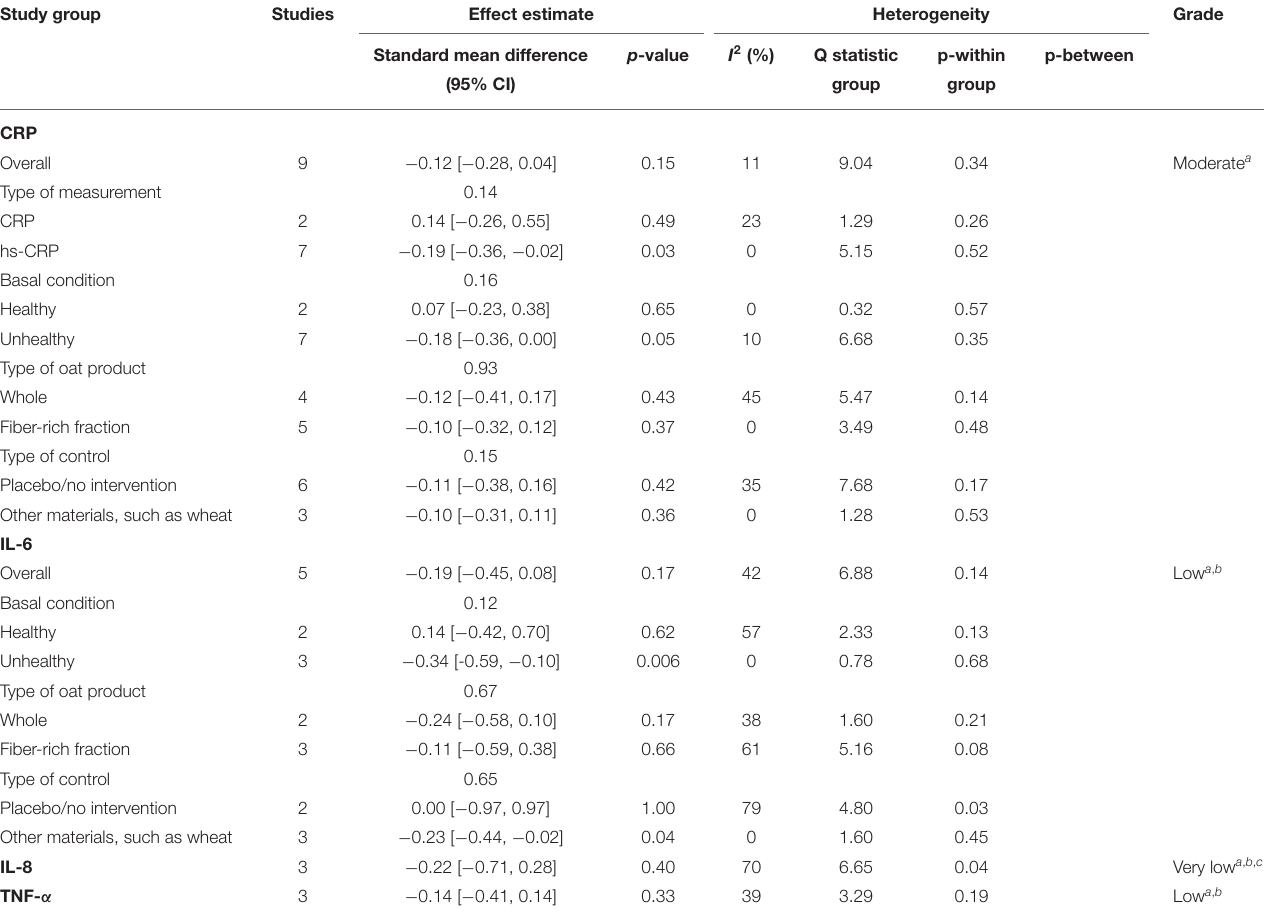
TABLE 4 | Summary of the results of this meta-analysis on C-reactive protein (CRP), interleukin-6 (IL-6), interleukin-8 (IL-8), and tumor necrosis factor alpha (TNF- α ). Study group Studies Effect estimate Heterogeneity Grade Standard mean difference Q statistic